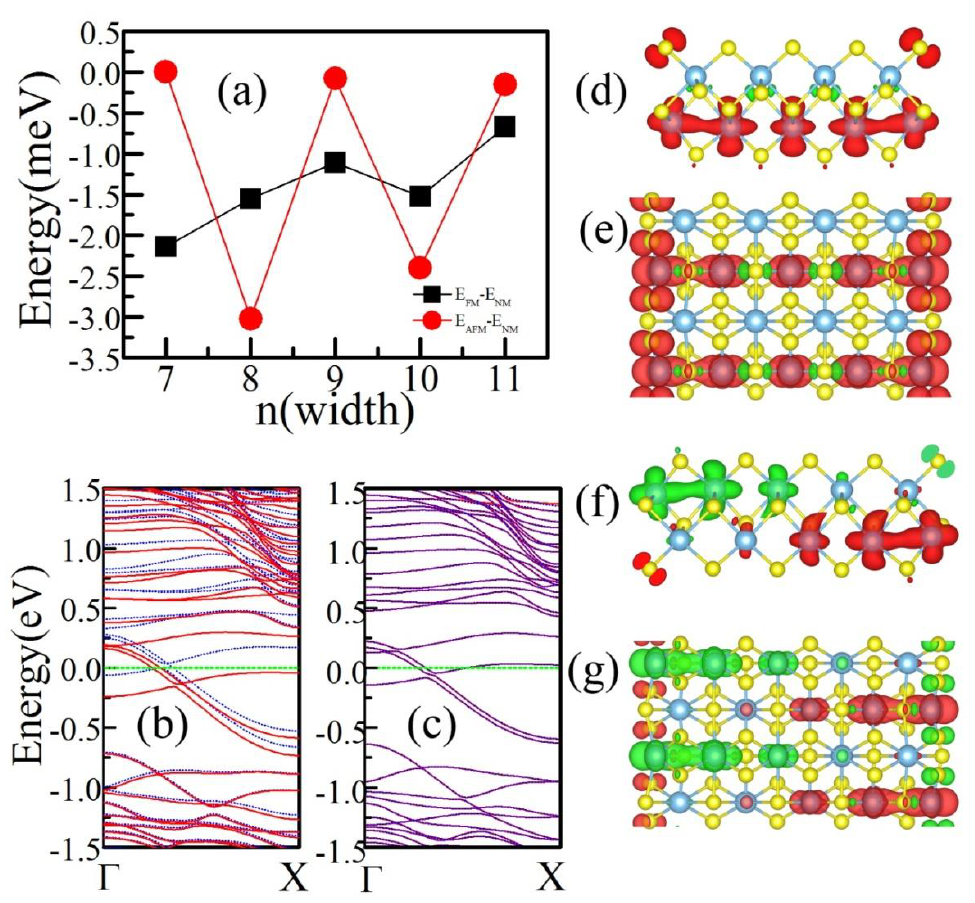
Figure 3. ( a ) The energy of magnetic ground state changes as the width of a -TiS 3 NR. ( b ) The spin-polarized band structure of the FM ground state of 9- a -TiS 3 NR, red lines (blue dashed lines) indicate spin up (down) component. ( c ) The spin-polarized band structure of AFM ground state of 10- a -TiS 3 , red lines (blue dashed lines) denote spin up (down) component. ( d ) and ( e ) are spin density of FM state of 9- a -TiS 3 NR, ( d ) is the side view from the period direction of a -TiS 3 NR and ( e ) is the top view. ( f ) and ( g ) are the spin density of the AFM state of 10- a -TiS 3 NR, ( f ) is side view from the period direction of 10- a -TiS 3 NR and ( g ) is the top view.